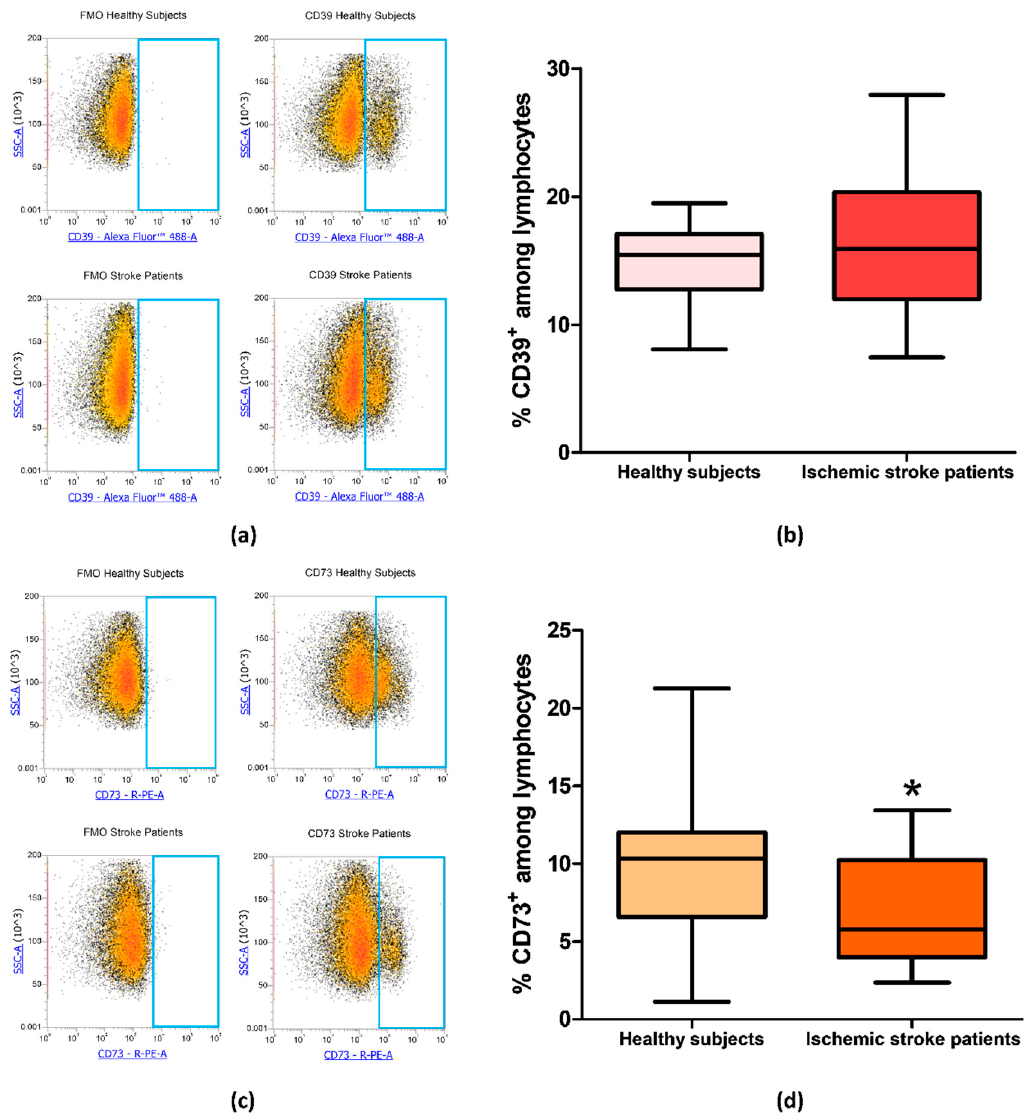
Figure 3. ( a ) Representative flow cytometry density plots showing FMO control and CD39 stained cells in lymphocytes from healthy subjects and ischemic stroke patients. ( b ) Graphical representation of flow cytometry data showing the percentage of CD39 + lymphocytes in healthy subjects (n = 20) and ischemic stroke patients (n = 21) . ( c ) Representative density plots showing FMO control CD73 stained cells in lymphocytes from healthy subjects and ischemic stroke patients. ( d ) Box and whiskers plot showing the percentage of CD73 + lymphocytes in healthy subjects (n = 20) and ischemic stroke patients (n = 21) . Data are shown as the median, interquartile range and the minimum and maximum values. * p < 0.05 vs healthy subjects.